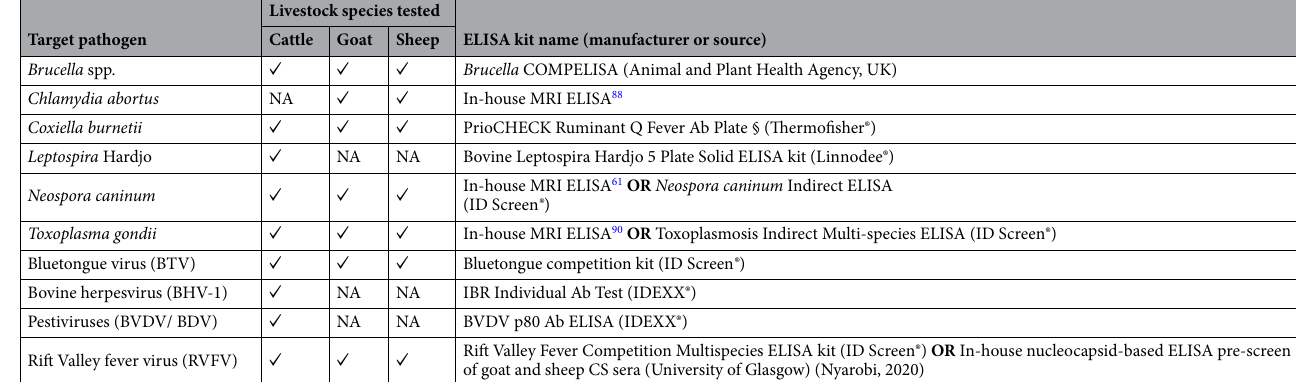
Table 3. Cross-sectional and abortion cohort serological tests (ELISA) for abortigenic pathogens used for various livestock species, northern Tanzania, 2013–2019. For Leptospira, BHV-1 and BVDV, serological testing of goat and sheep sera was not performed because the ELISA kits were not validated for small ruminant sera. KCRI Kilimanjaro Clinical Research Institute, Moshi, Tanzania, MRI Moredun Research Institute, UK, NA not applicable, test not done. § Formerly known as LSIVet Ruminant Q fever